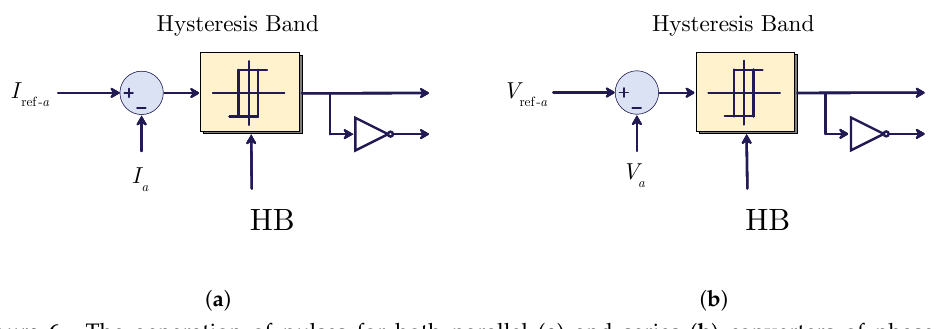
Figure 6. The generation of pulses for both parallel ( a ) and series ( b ) converters of phase a through AHB.